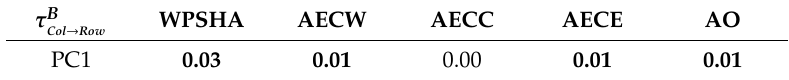
Table 3. Information flow (IF) τ B values between PC1 and the atmospheric circulation indices-based Col → Row predictors (bold font indicates statistically significant values at the 5% level, and 0.00 means the value is less than 0.005; the same applies to the following tables).